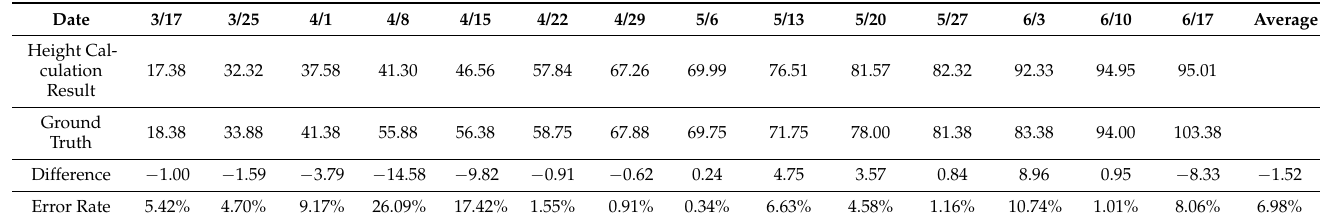
Table 8. Field 2—Comparison of Height Calculation Based on Image and Ground